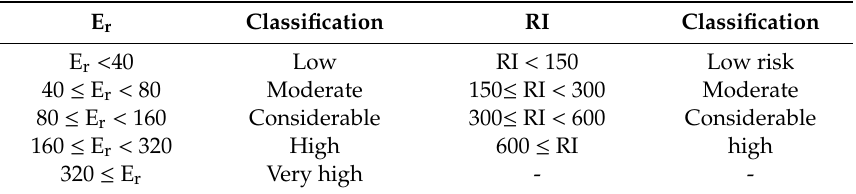
Table 1. PERI classification standards for